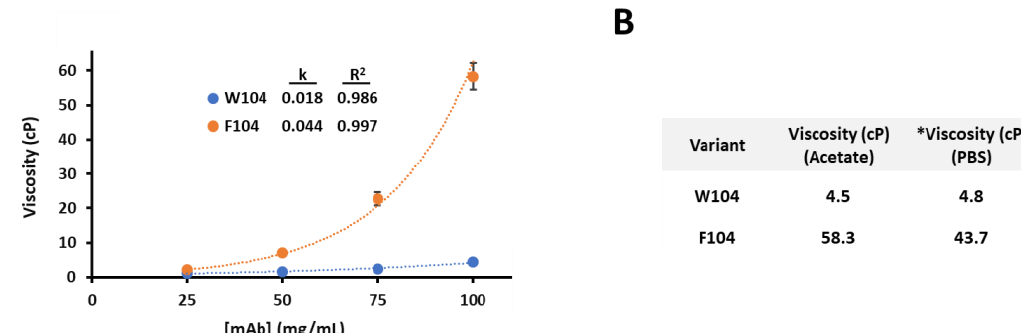
Figure 1. ( A ) Viscosity (dynamic) versus mAb concentration for W104 (blue circles) and F104 (orange circles) IgG1 mAb variants in 20 mM Sodium Acetate pH 5.5 from 25–100 mg/mL. Each viscosity curve was fit to the equation y = Ae kx , where the exponential factor (k) and R 2 of the fit are given for each variant. ( B ) Table of viscosities for the two W104 and F104 mAb variants in both 20 mM Acetate pH 5.5 and PBS pH 7.4 at 100 mg/mL. * Previously reported [6].